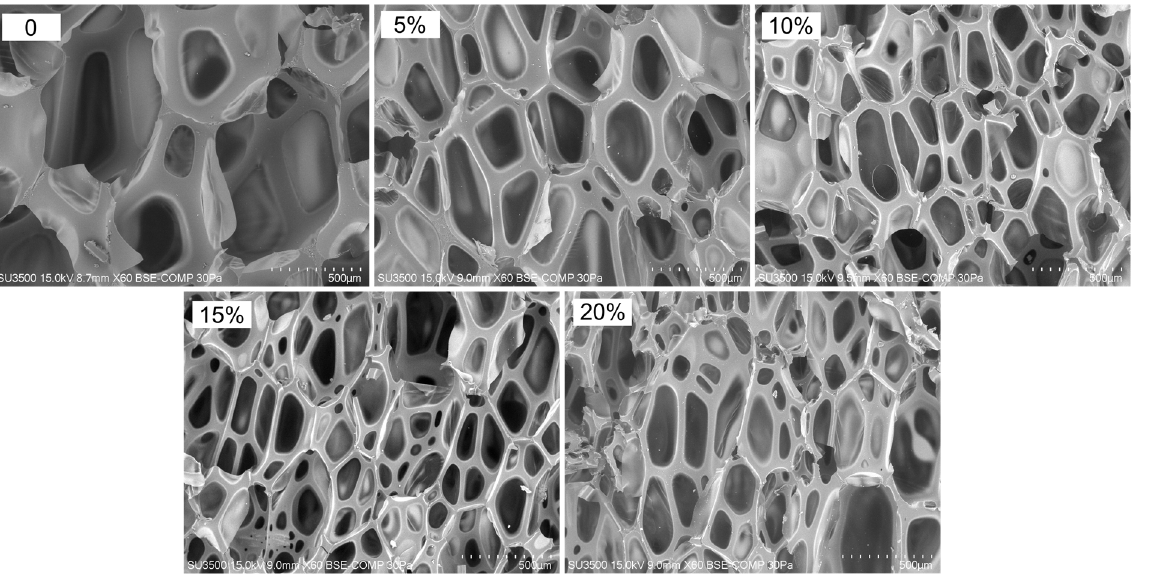
Figure 5. SEM micrographs of PUR showing changes in cell wall structure under the influence of sawdust application.